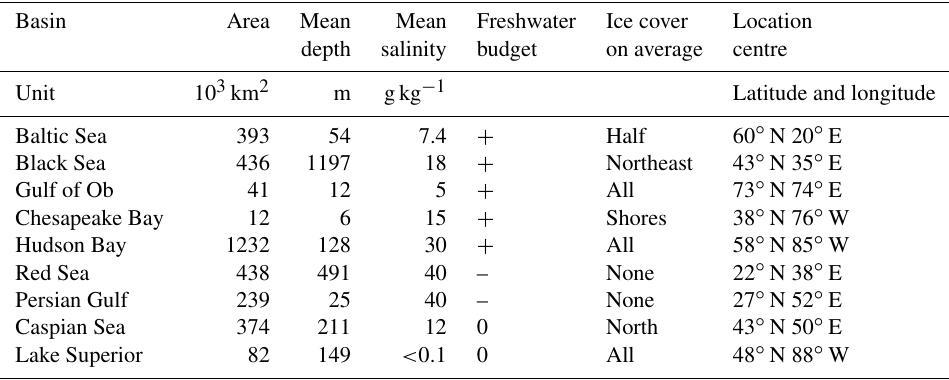
Table 4. Comparison of the Baltic Sea with other intracontinental seas and large lakes. Basin Area Mean